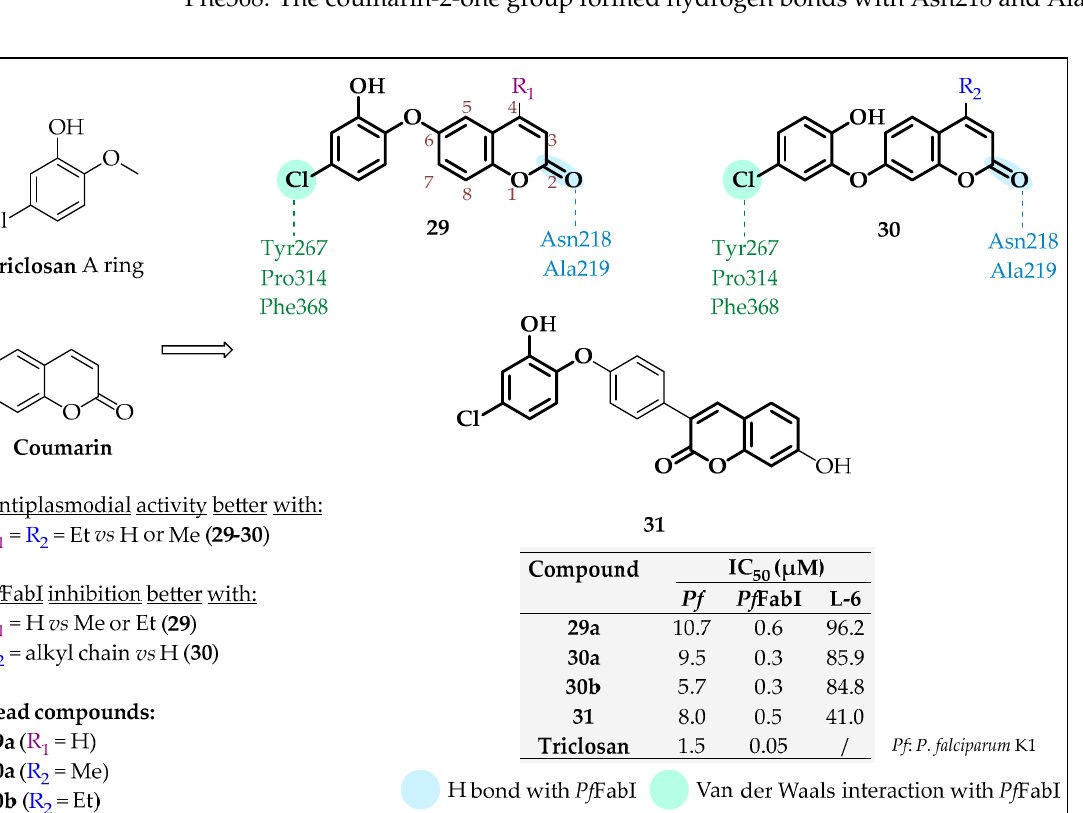
Figure 29. Structure, SAR and representation of main interactions with Pf FabI of triclosan derivatives 29–31 and in vitro activities of lead compounds [132].